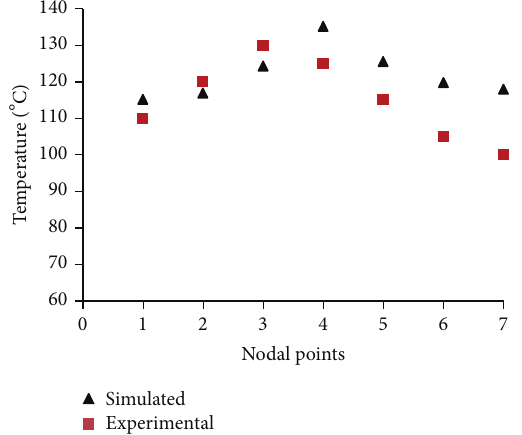
Figure 8: Temperature distribution at three-quarters load.